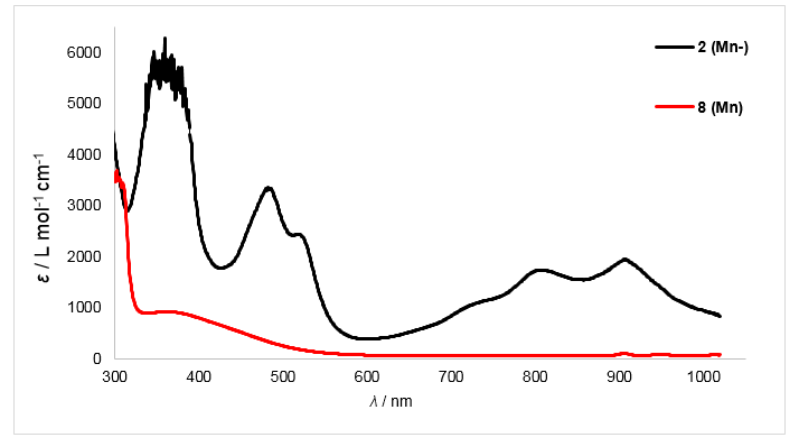
/ Vis spectra of the manganese complexes 2 (Mn − ) and 6 Figure 6. Overlay of UV/Vis spectra of the manganese complexes 2 (Mn − ) and 6 (Mn). Figure 6. Overlay of UV